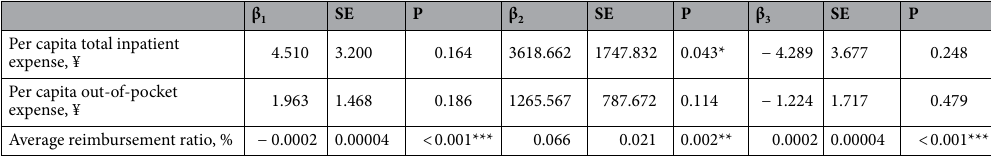
Table 3. Interrupted time-series analysis of the impact of integrated medical insurance on the main indicators. β coefficient, SE standard error. *, ** and *** denote P < 0.05, 0.01 and 0.001, respectively.